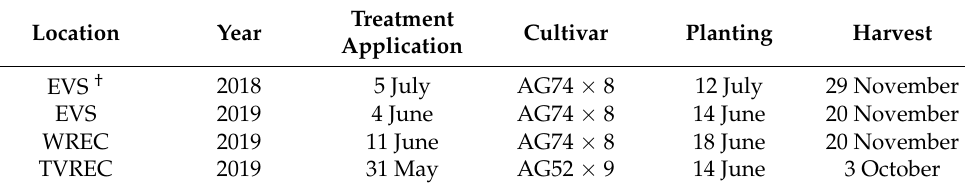
Table 2. Cultural practices adopted in the study at the experimental